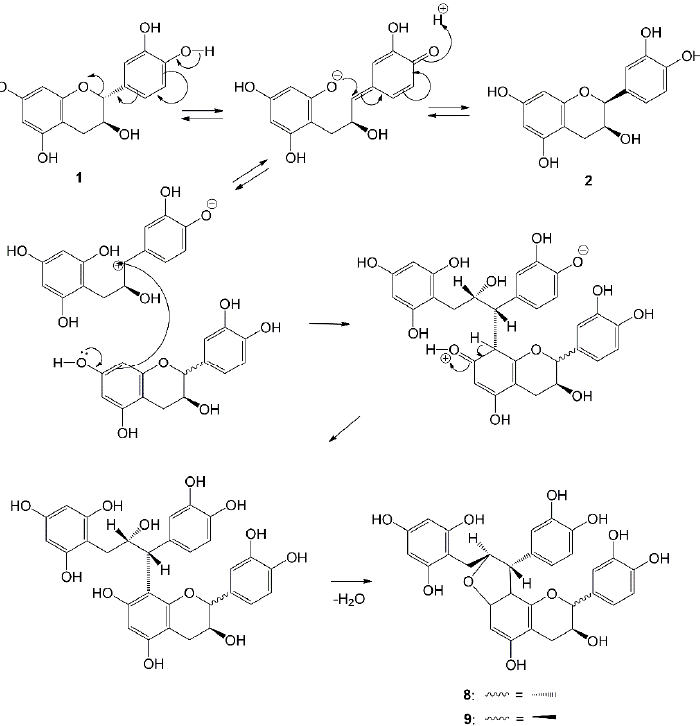
Figure 3. Mechanism for the Formation of Chalcane-Flavan Dimers from catechin ( 1 ) and or epicatechin ( 2 ).